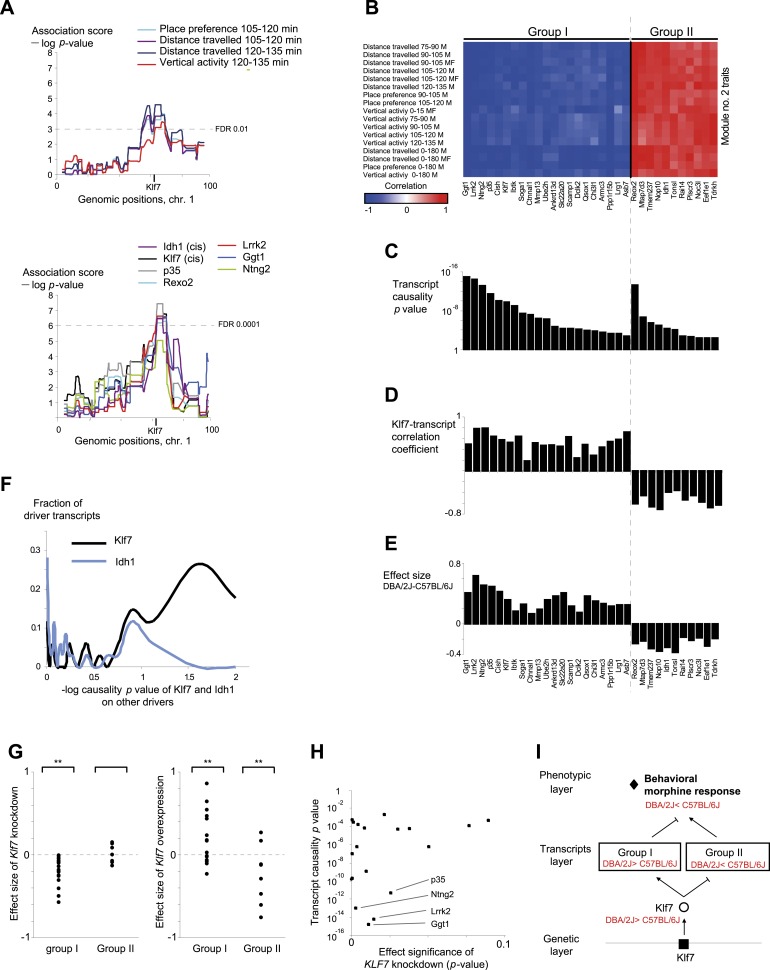
Characteristics of module no. 2.(A) Genetic associations. Shown are the association scores (y-axis) across the genomic positions of chromosome 1 (x-axis) for four module traits (top) and for seven selected drivers (bottom) in myeloid cells. The position of the Klf7 gene is marked below the x-axis. (B–E) Characterization of driver groups I and II. (B) A matrix of traits (rows) vs drivers (columns), where the blue/red scale indicates negative/positive Pearson correlation coefficients among them. (C) The transcript causality p value scores (y-axis) are shown for each module transcript (log scale), assuming a representative variant in the module's genomic interval (rs13475891 in chr1:62 Mbp). (D) The histogram represents the Pearson correlation coefficient (y-axis) of Klf7 with the remaining drivers (x-axis). (E) Genetic effect size of variant rs13475891 on the driver transcripts. The histogram represents the average expression levels of DBA2-carrying individuals minus the B6-carrying individuals (y-axis) for each module driver (x-axis). (F) Distribution of the causality −log p value scores of Idh1 (blue) and of Klf7 (black) on each of the remaining drivers in the module. Causality p values were calculated by positioning Idh1 or Klf7 between the module variant and a driver from this module. (G) Validation of the effect size of Klf7 perturbation of knockdown (left) or overexpression (right) on other drivers in bone-marrow hematopoietic stem cells (y-axis). The ‘effect size’ of perturbation (either knockdown or overexpression) on a certain transcript g is defined as the difference between the (log-scaled) expression of g in normal cells to that in the perturbed cells. In each panel, the first and second columns refer to groups I and II, respectively. **a significant t-test p value for determining whether the mean effect size is different from zero (FDR < 0.06). (H) Scatter plot, where for each driver in group I (a black square) the y-axis shows the transcript causality score (for morphine-response traits in this module; p values), and the x-axis shows the significance of Klf7 knockdown effect on its transcription level (t-test p value). The plot indicates that in group I, drivers with highly significant causality on behavioral responses to morphine were also significantly influenced by Klf7 knockdown. (I) Overall model illustration of module no. 2.